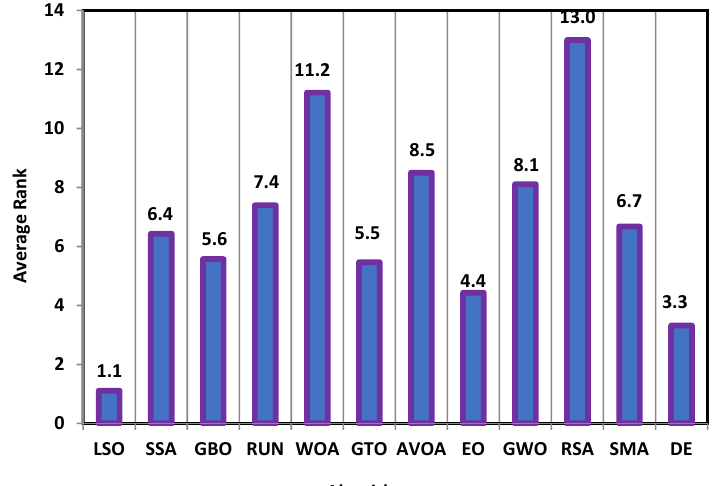
Figure 11. Average rank on all CEC2017 test functions.